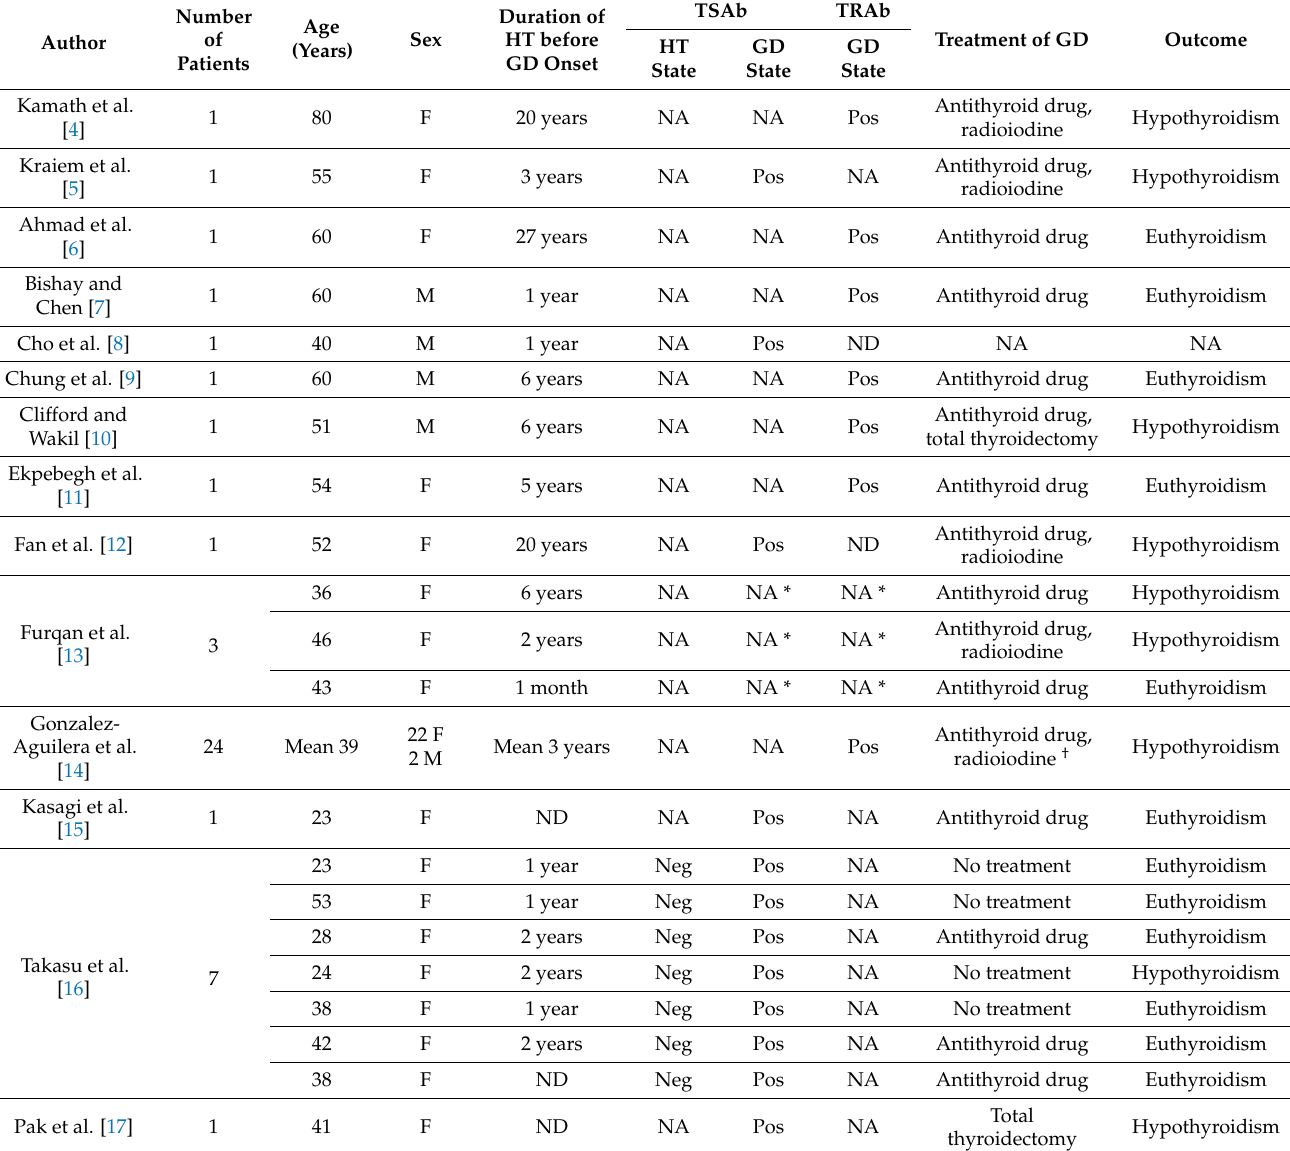
Table 1. Conversion to Graves’ disease from Hashimoto’s thyroiditis: reported